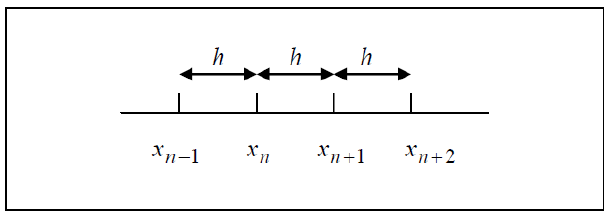
Figure 1. 2-point SDIBBDF method of constant step